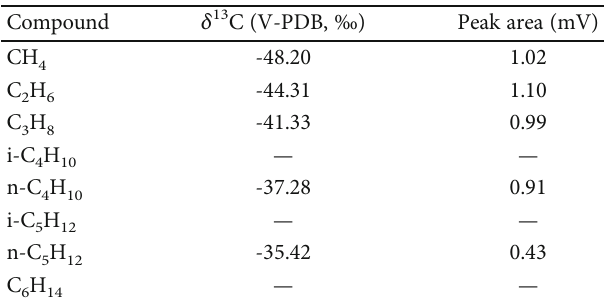
Table 2: Composition and peak area of natural gas sample from